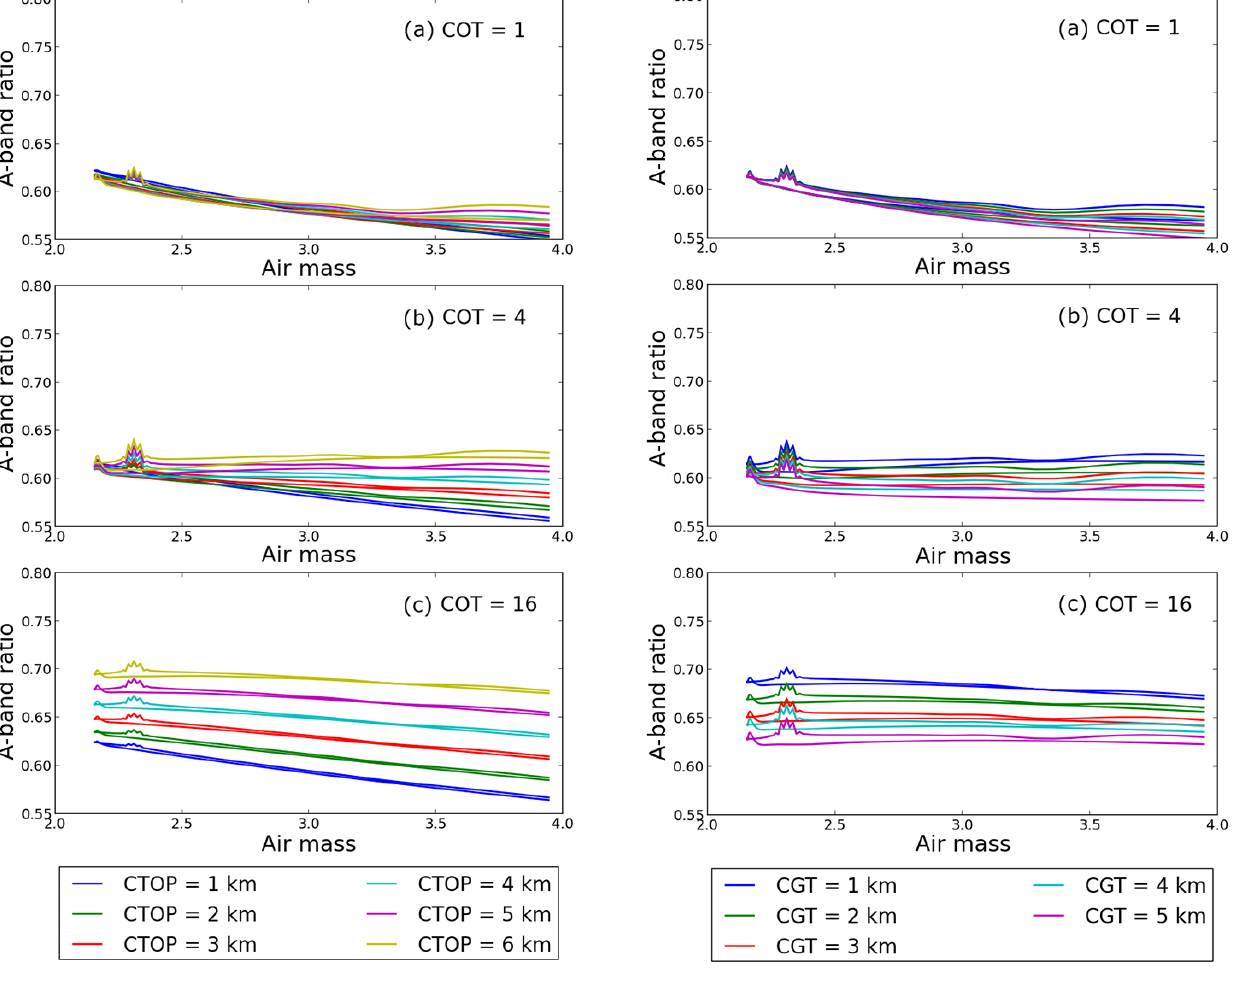
Figure 9. Same as Figs. 4 and 7 with a surface albedo of 0.8. (a) COT = 1, (b) COT = 4, (c) COT = 16.